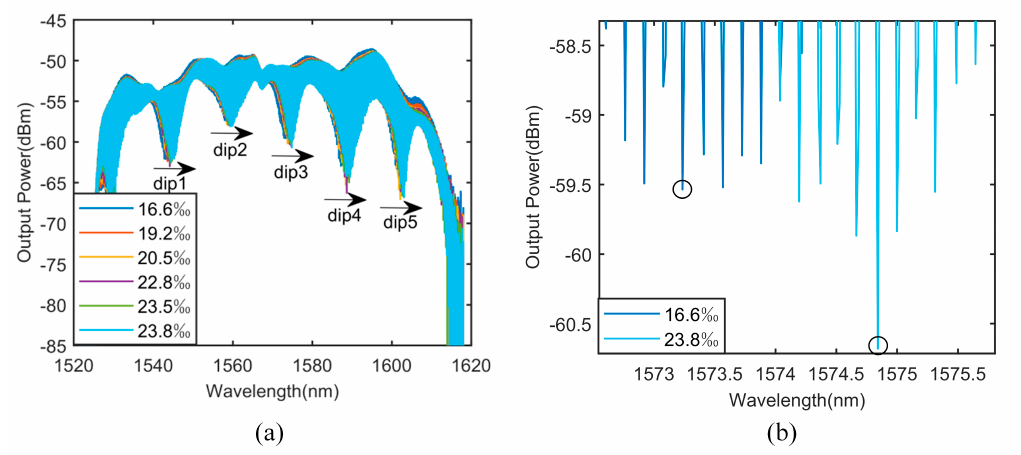
Figure 8. ( a ) The output spectra at different salinities with L = 7 mm, r = 1.55, l a = 6 mm. ( b ) Detail of output spectra near dip3.